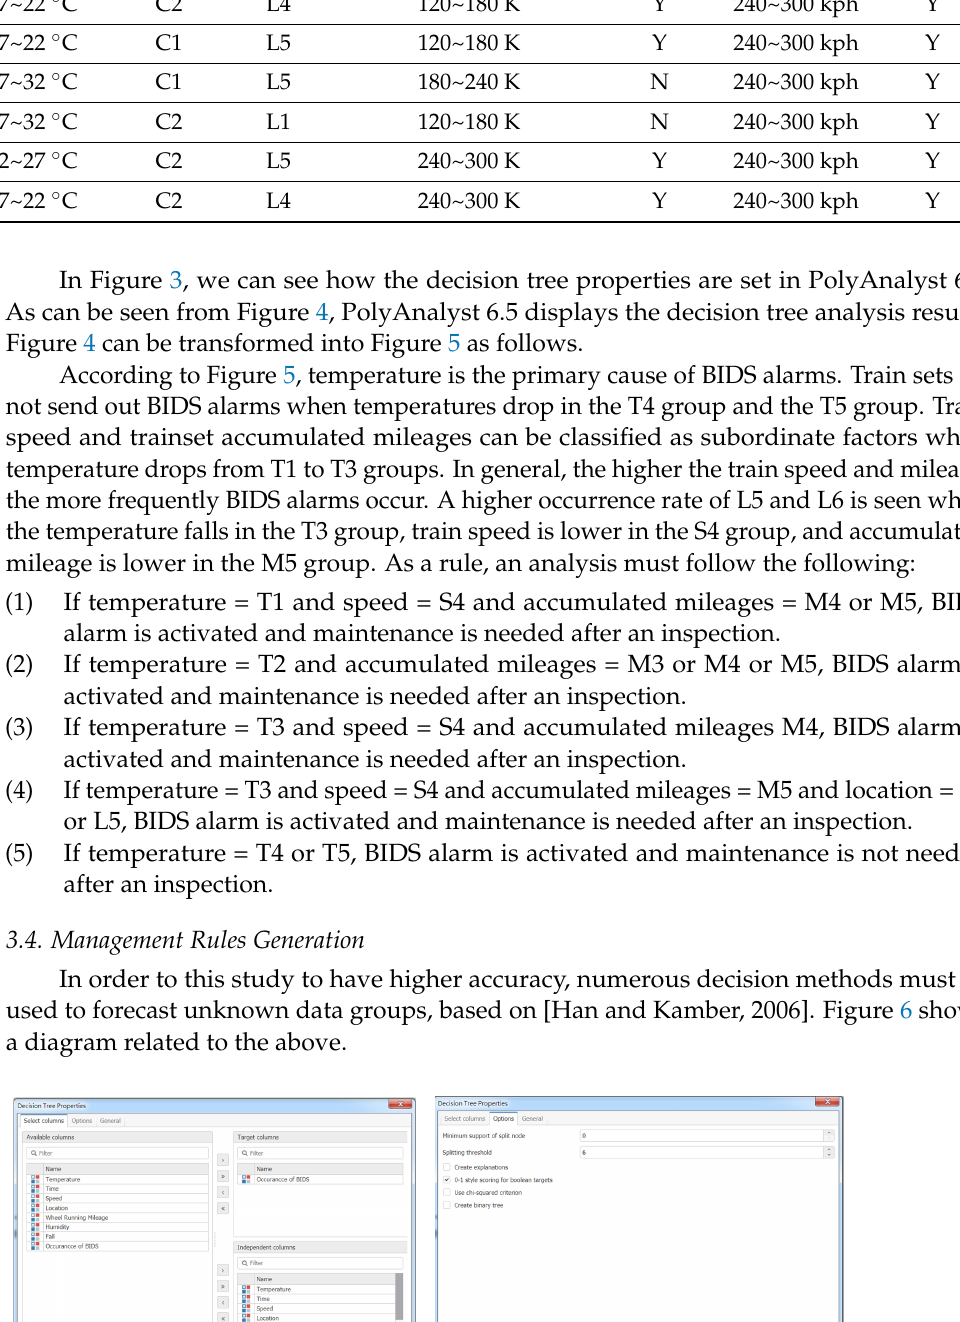
Figure 3. Screenshots of the PolyAnalyst 6.5 decision tree properties settings.